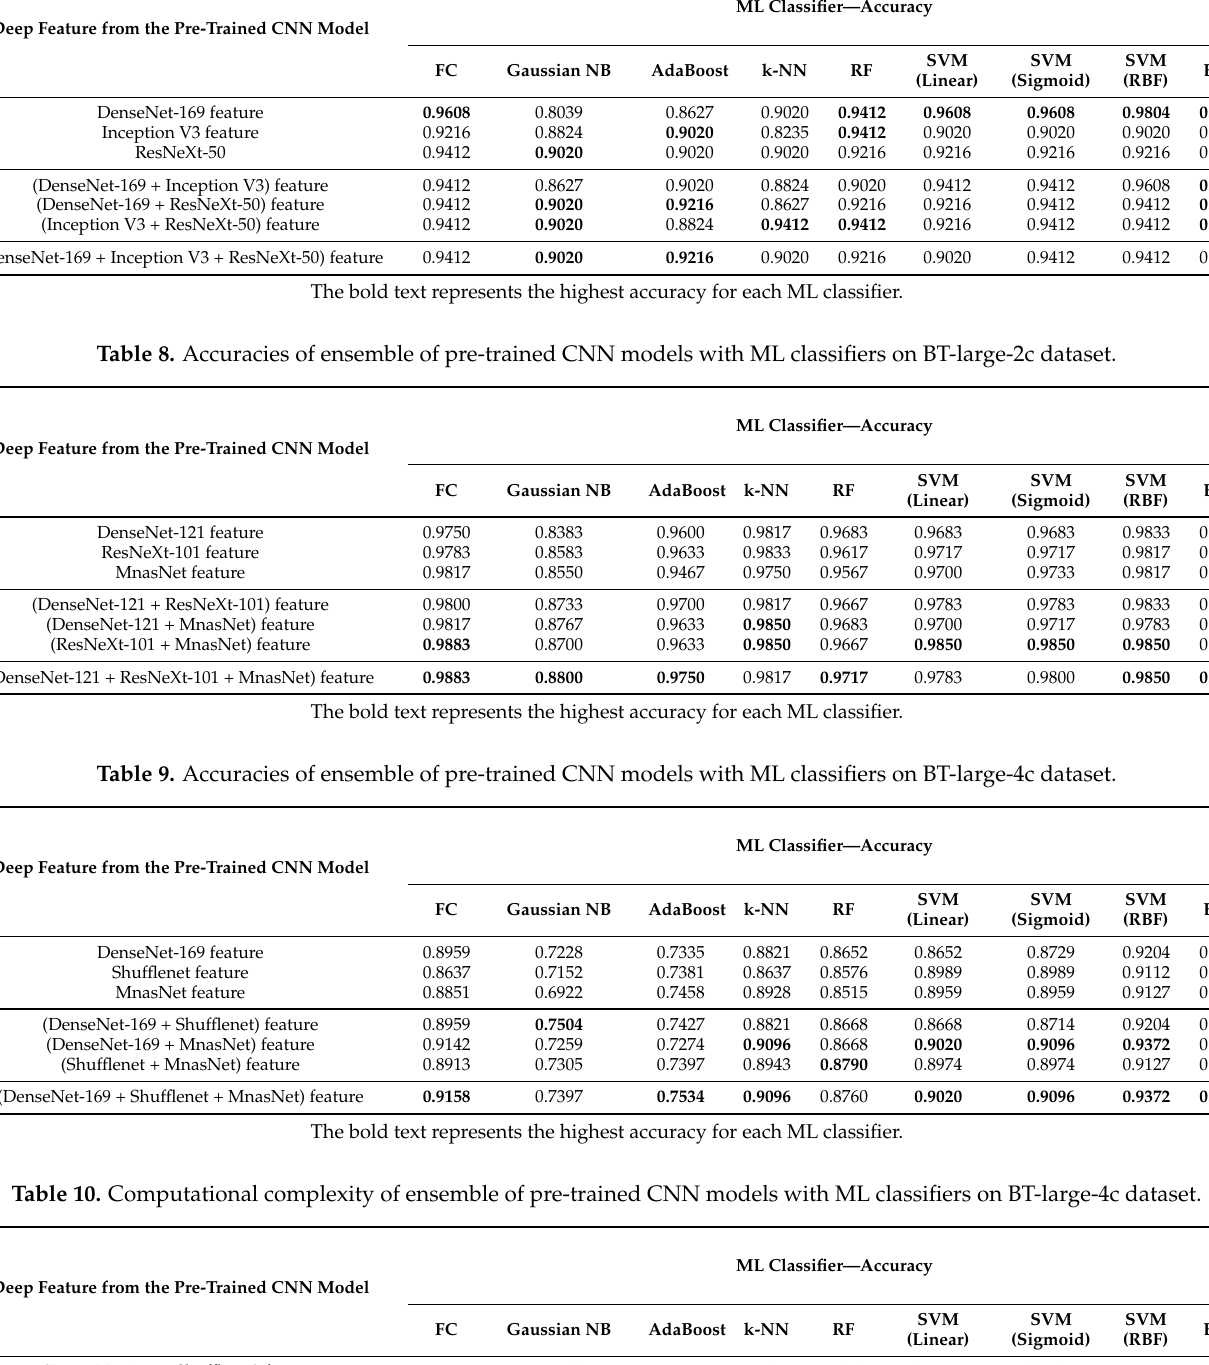
Deep Feature from the Pre-Trained CNN Model